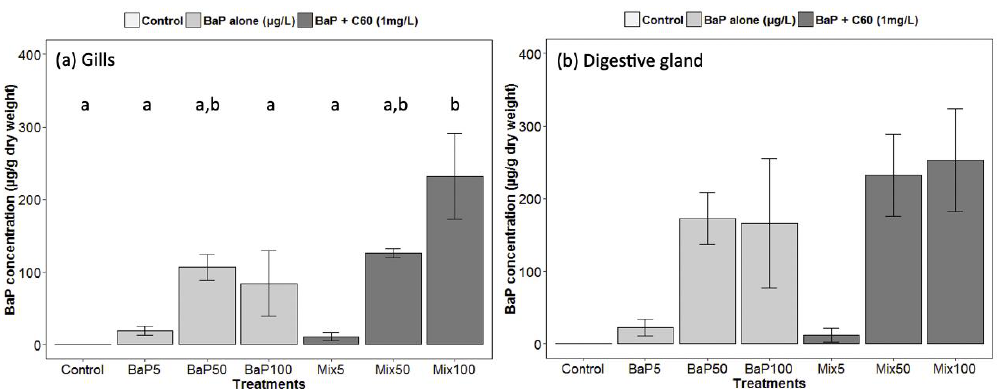
Figure 1. Gas Chromatography − Mass Spectrometry (GC–MS) analyses of B[a]P in ( a ) gills and ( b ) digestive gland of M. galloprovincialis . Data marked with different letters differed significantly (Tukey post-hoc test; p < 0.05).